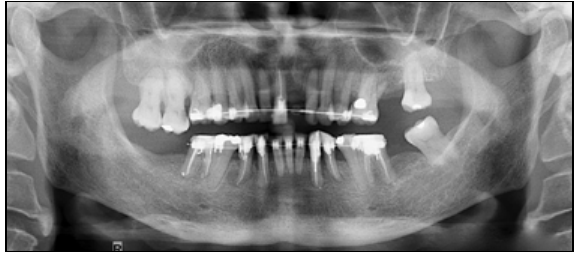
Figure 8. A progress panoramic radiograph taken 10 months into active orthodontic treatment. No significant progression in periodontal attachment loss has